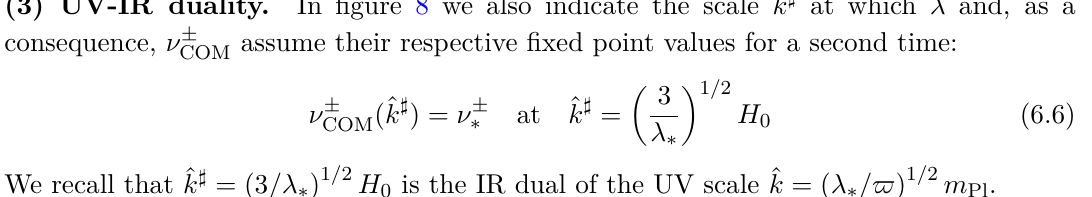
( k ) 2 − 1 (lower graph), respectively. COM 4